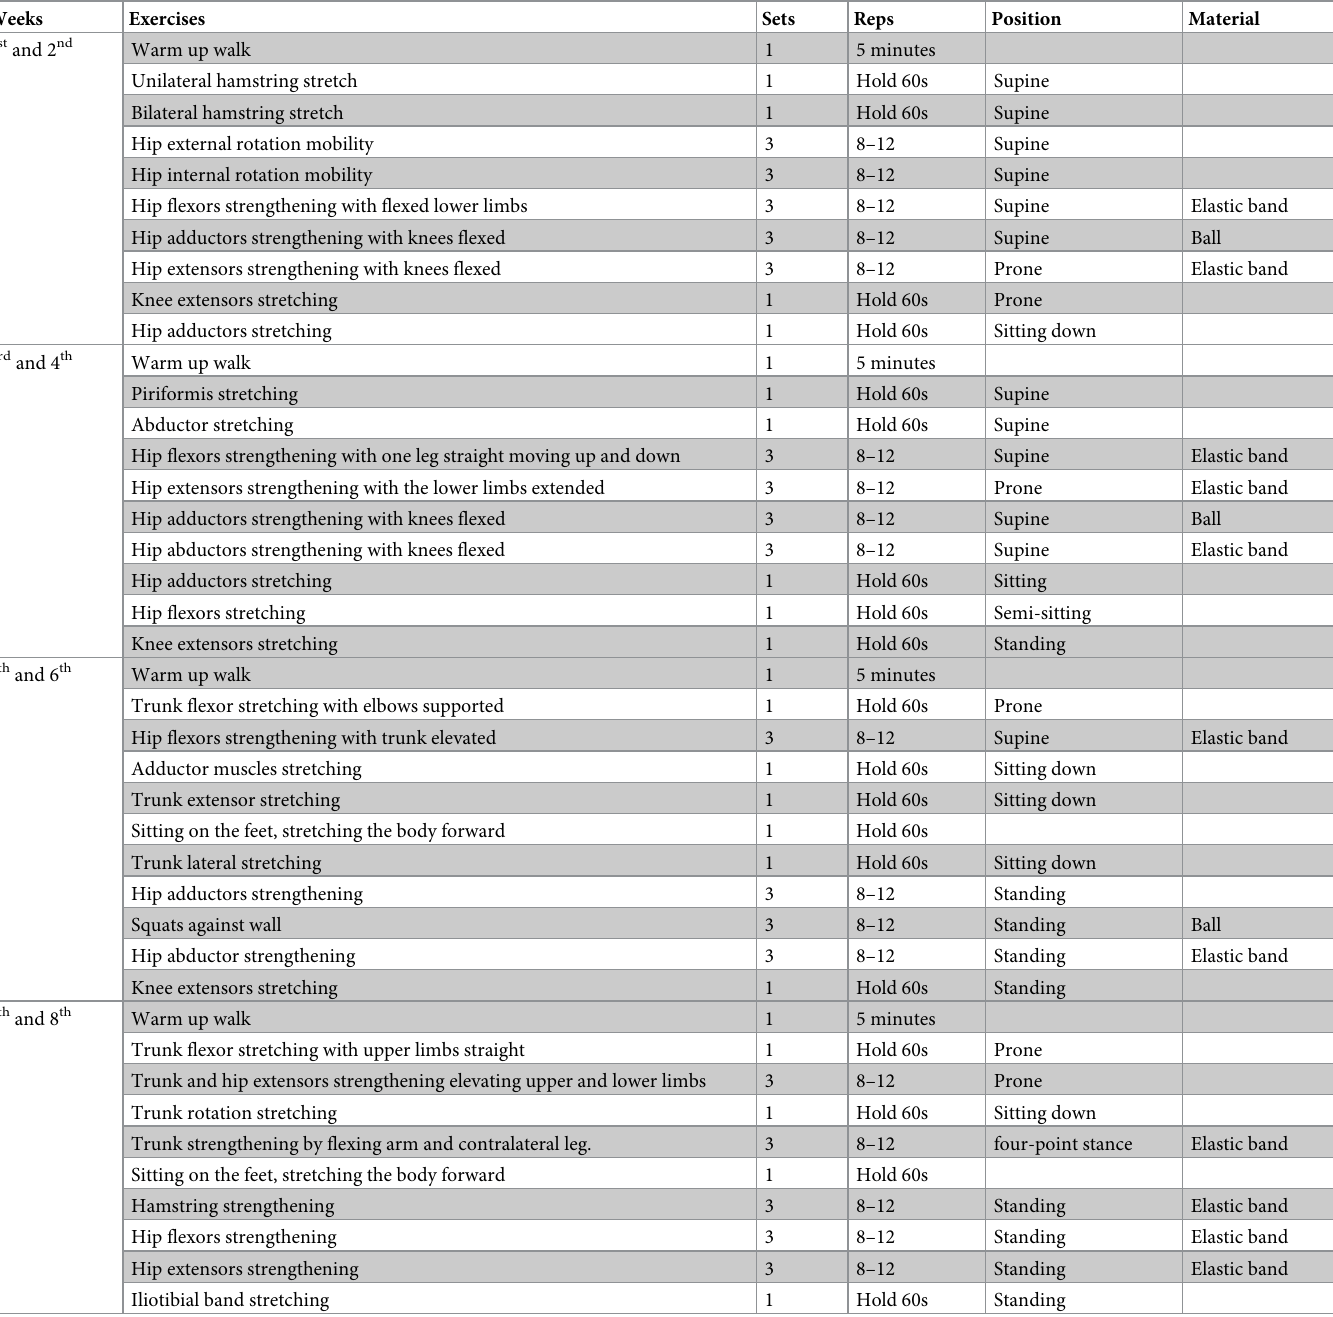
Table 2. Exercise dosage and progression of general